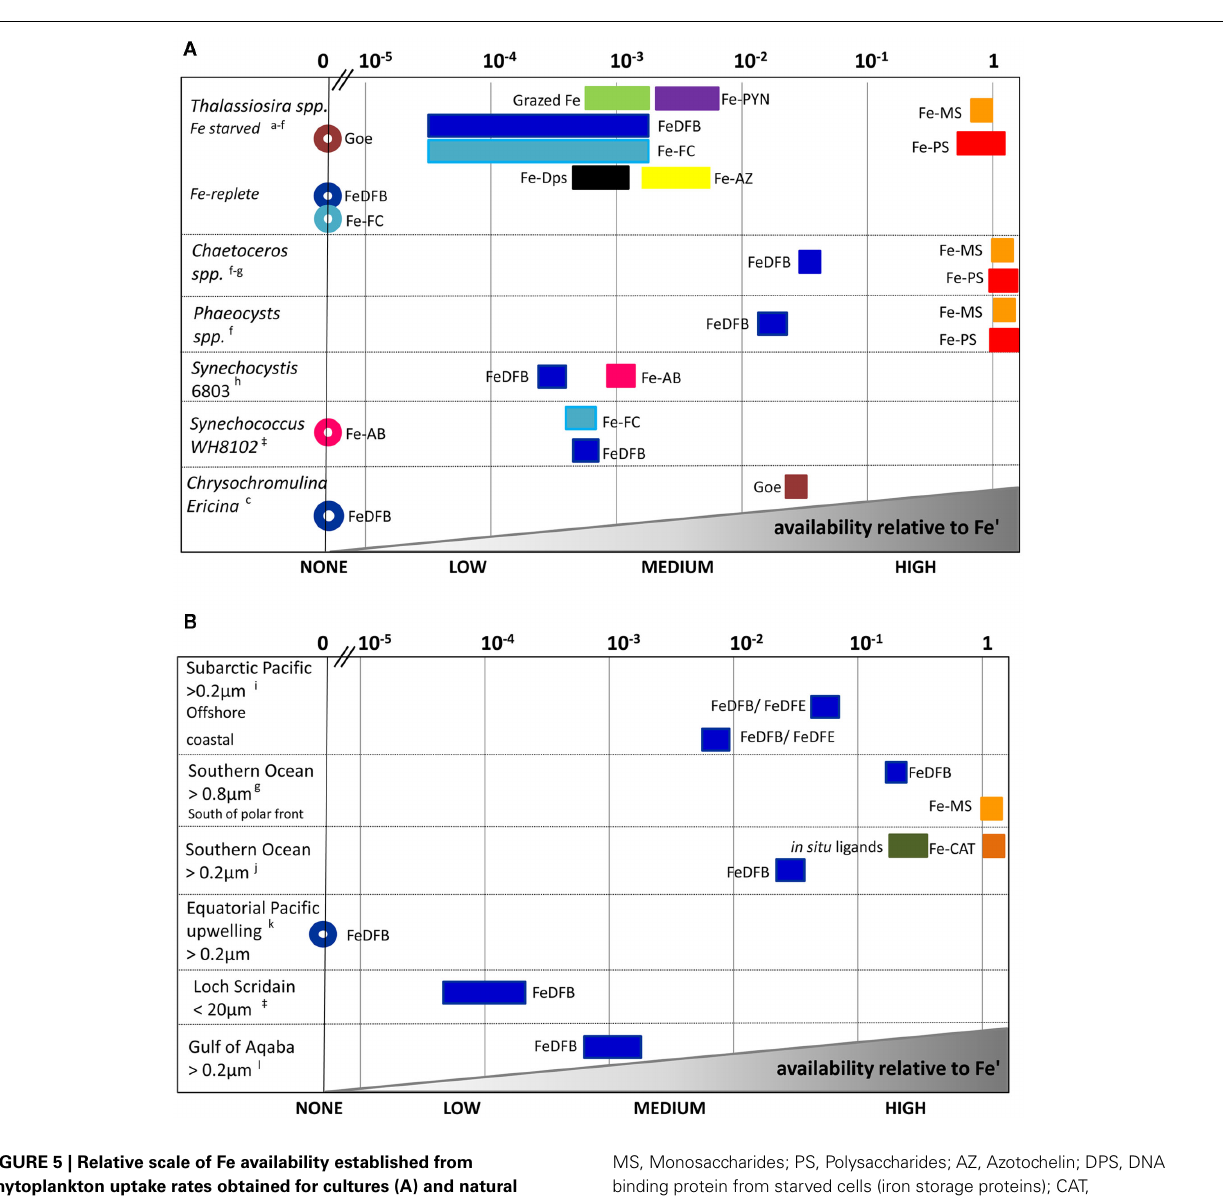
MS, Monosaccharides; PS, Polysaccharides; AZ, Azotochelin; DPS, DNA binding protein from starved cells (iron storage proteins); CAT, Gallocatechin; DFE, desferrioxamine E. See Appendix for supporting data and Figure 3 for location descriptions. References: a Shaked et al. (2005), b Chen andWang (2008), c Nodwell and Price (2001), d Kustka et al. (2005), e Maldonado and Price (2001), f Hassler and Schoemann (2009), g Hassler et al. (2011b), h Kranzler et al. (2011), i Maldonado and Price (1999), j Maldonado et al. (2005), k Wells et al. (1994); l Lis and Shaked (2009), ‡ Lis and Shaked,